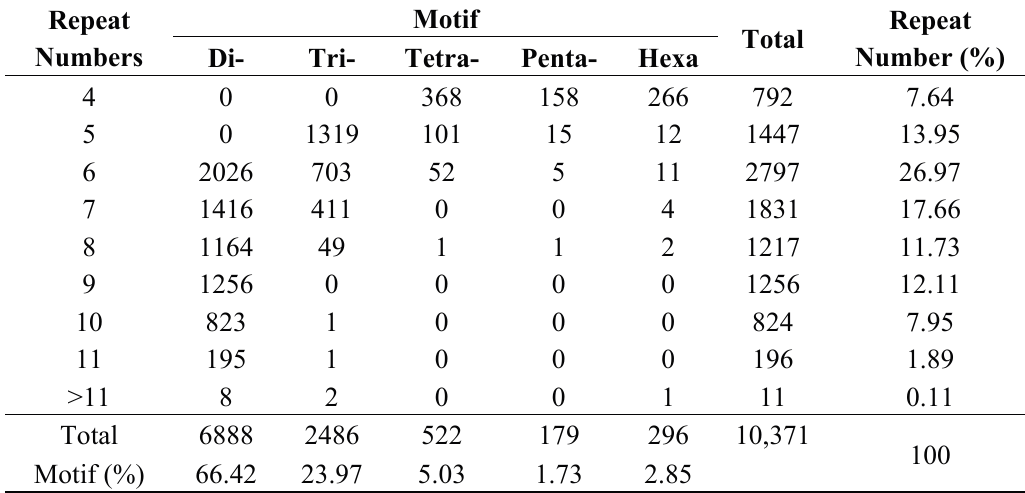
Figure 6. Frequency distribution of SSRs based on the motif types. Table 2. The distribution of the identified EST-SSRs in sequences using the MISA (MIcroSAtellite identification)